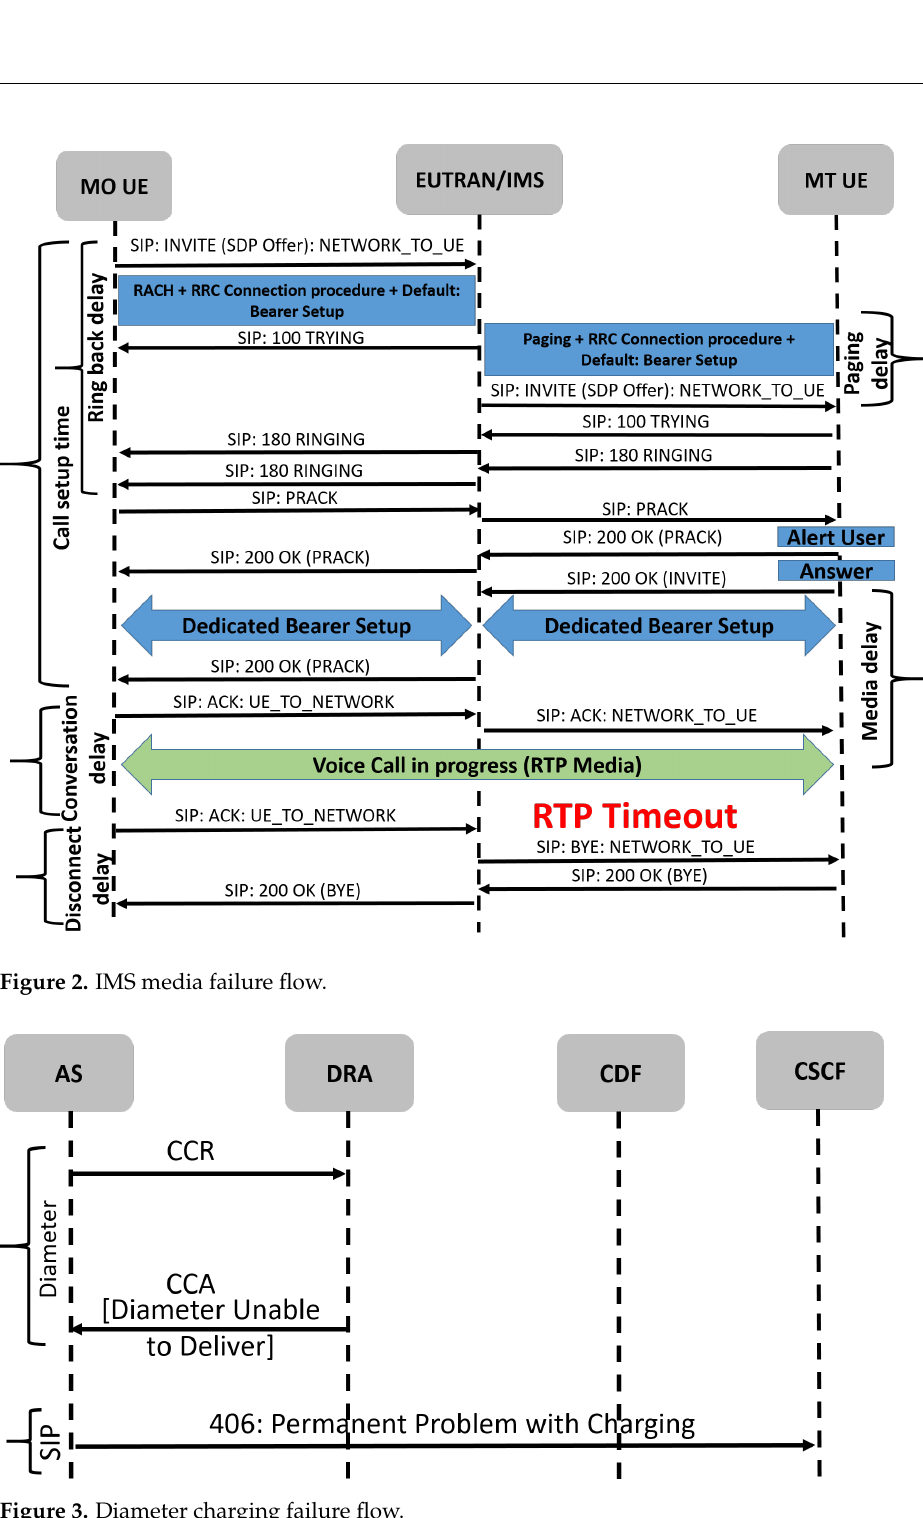
Figure 3. Diameter charging failure